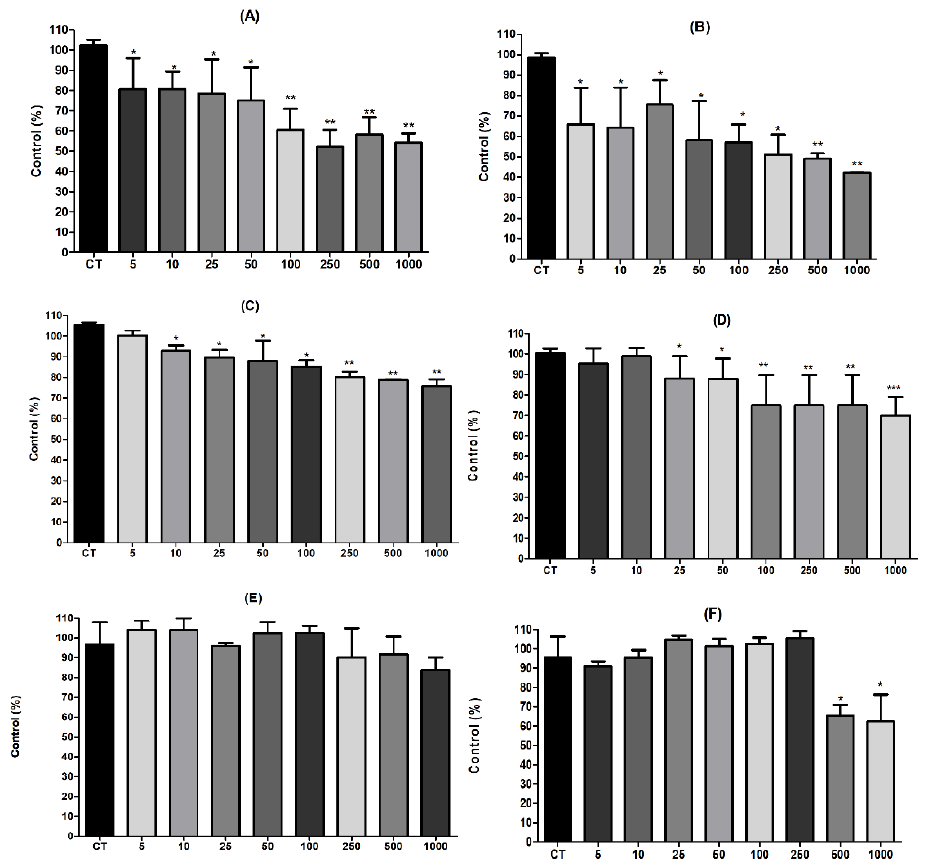
Figure 2. Effect of freeze-dried (FD) and dried peel powders (DP) extracts of M. jaboticaba FD-MJ ( A ) and DP-MJ ( B ), S. cumini FD-SC ( C ) and DP-SC ( D ) and S. malaccense FD-SM ( E ) and DP-SM ( F ) on viability HT-29 cells after 24 h of treatment (5 – 1000µg/mL). The results were compared by one-way ANOVA with the post-test of Tukey’s test (* p < 0.05; ** p < 0.01; *** p < 0.001).